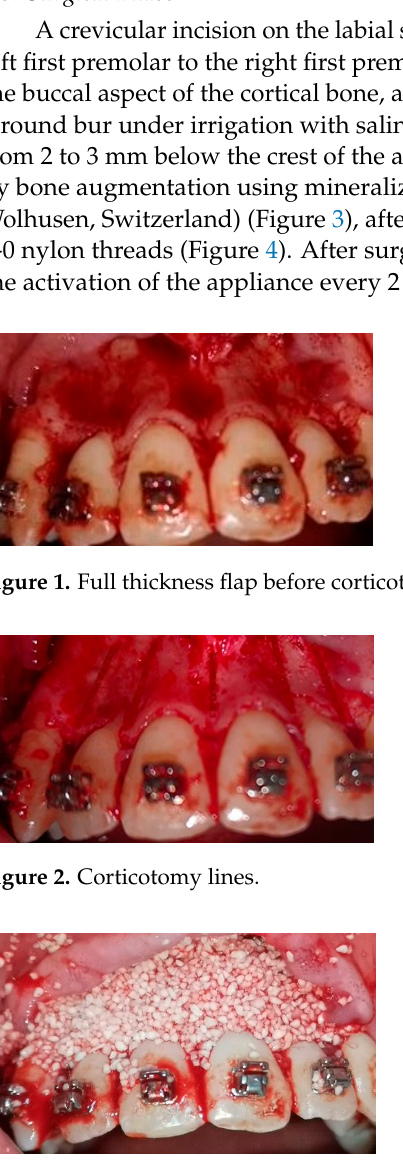
Figure 4. Sutures after the flap reposition. 2.6. Collection of the Radiological Data A second CBCT was made 6 months after the corticotomy (T1). The subjects under- went CBCT using a NewTom Vgi Dental Cone Beam Scanner from New Tom, Cefla SC, Bologna, Italy, with a tube voltage of 88 kV and a current intensity of 6mA, using a cylin- drical field of view of 80 mm both in diameter and height. The voxel size was 0.2 mm × 0.2 mm × 0.2 mm. After the measurements were made, the alveolar bone thickness was measured by importing DICOM filess into Mimics software (ver. 18.0; Materalise Mimics Medical, Leuven, Belgium) . Furthermore, in the sagittal view, a line was drawn at the cement enamel junction (CEJ) of the buccal surface. Afterwards, the following radiographic data were collected: the horizontal labial bone thickness measured at the height of 3 mm, 6 mm and 9 mm representing cervical, mid root (medial) and apical points, respectively, and the root length, measured from the CEJ to the apical level. All the radiographic measurements were performed by two orthodontists and a periodontist. 2.7. Statistical Analysis Statistical analysis included elements of descriptive statistics (mean, median and standard deviation) and elements of inferential statistics. The Shapiro–Wilk test was ap- plied to determine the distribution of the analyzed data series. For the comparison of means and medians the Student t-test was applied for paired and unpaired data, respec- tively, using the Wilcoxon test and the Mann–Whitney test. The significance threshold for p was 0.05. Statistical analysis was performed using the GraphPad prism trial version, GraphPad Software, San Diego,USA) 3. Results A total of 60 patients, 32 females (with a mean age range of 39.50 ± 7.87 years) and 28 males (with a mean age range 30.73 ± 6.21 years), were included in this study. Tables 1 and 2 show the values of the buccal cortical bone thickness measured at T0 and T1 in both females and males, upper and lower arch. For both arches, the most significant changes were observed at the cervical level. In the upper arch, for females at T0 and at T1, 1.36 ± 0.27 mm and 1.82 ± 0.53 mm were measured, respectively. In males, at T0, 1.56 ± 0.36 mm was measured, and at T1, 2.20 ± 0.56 mm. Statistically significant values were obtained at all three levels at which measurements were made.